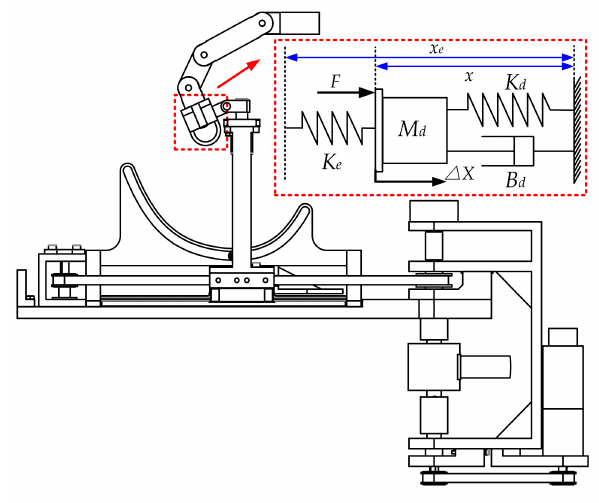
Figure 12. The equivalent model of the single module in contact with the environment.